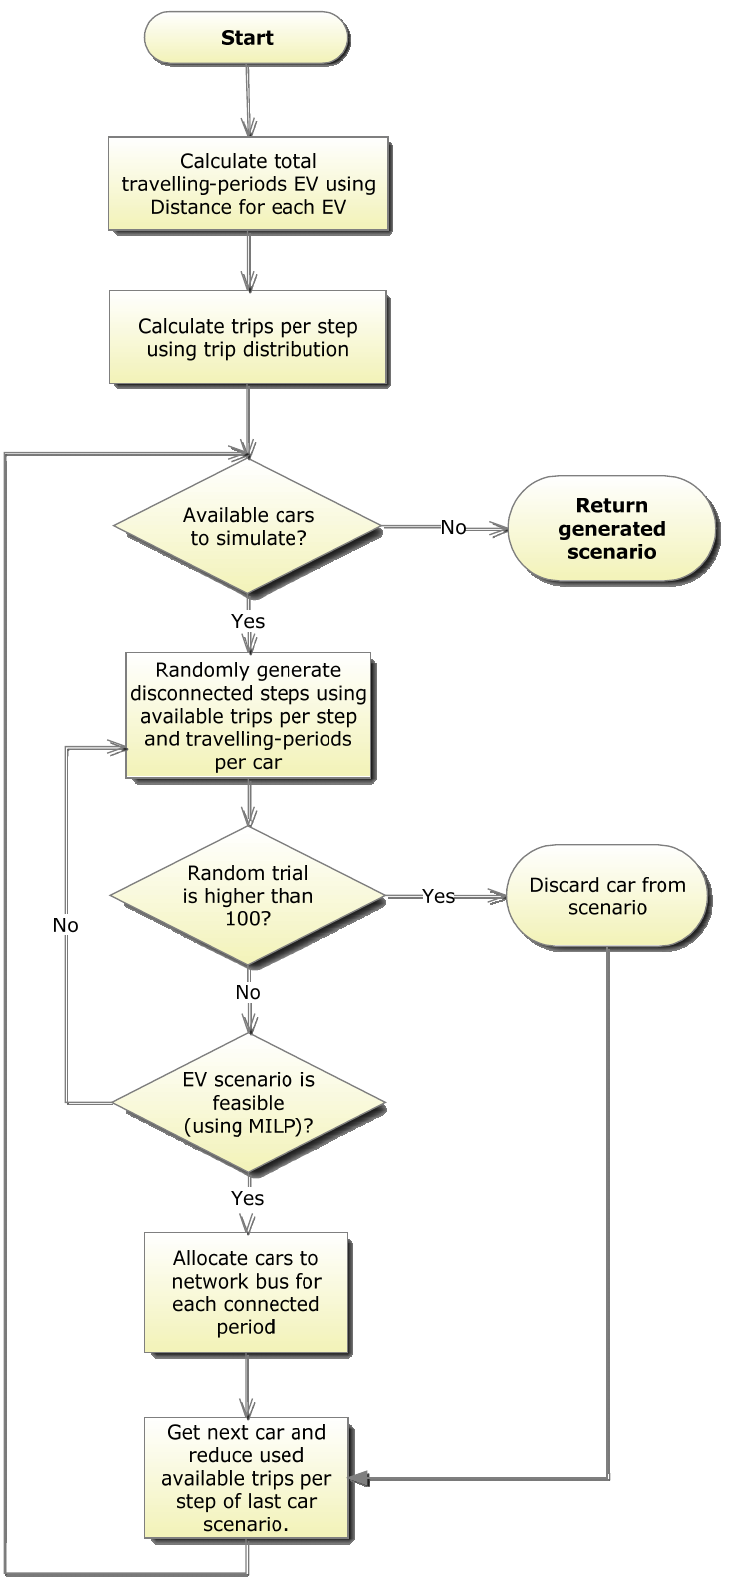
Figure 6. Module 2 algorithm